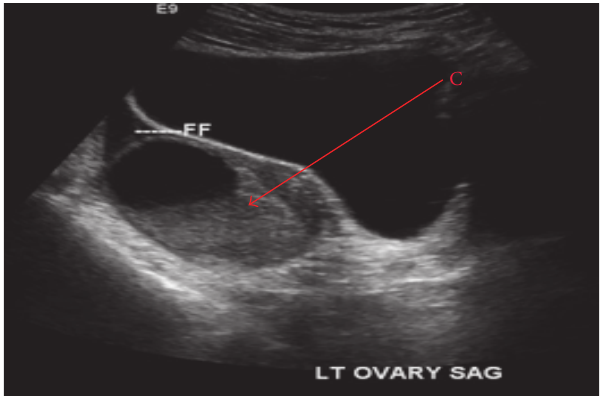
Figure 2: US. C: adnexal